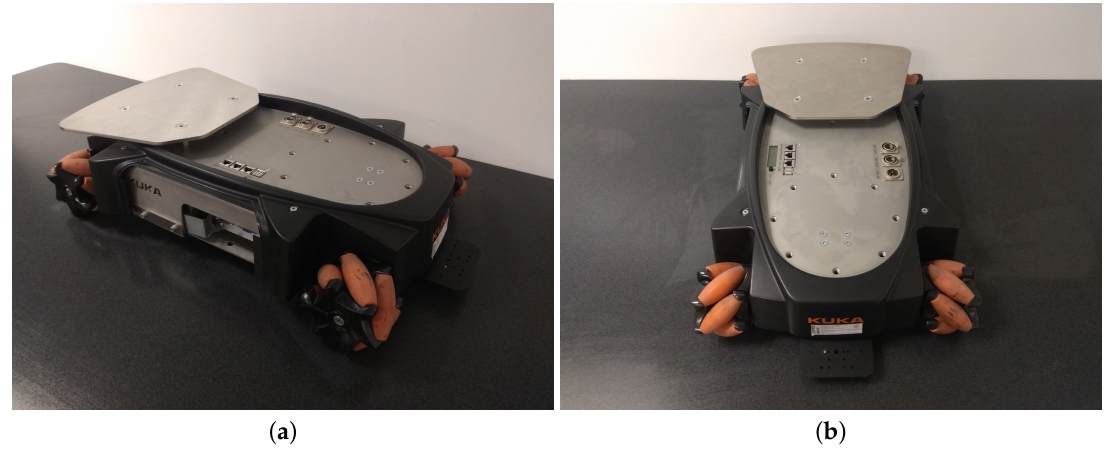
Figure 18. Omnidirectional KUKA ® Youbot ® platform. ( a ) side and ( b ) front